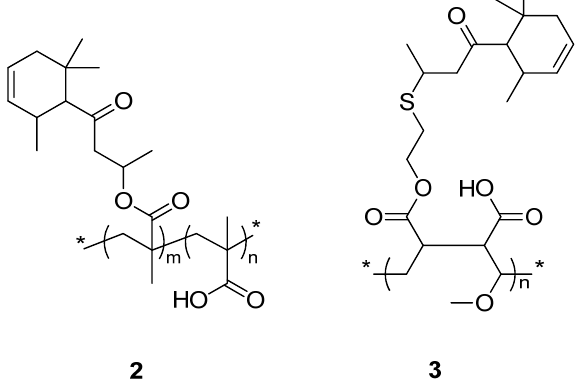
Figure 2. Examples of polymer conjugates of δ -damascone investigated in previous work